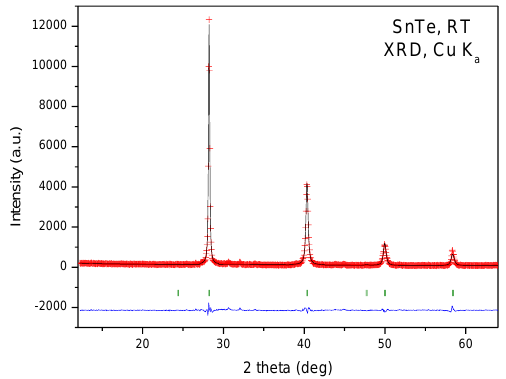
Figure 1. XRD pattern of SnTe from laboratory equipment, with Cu Kα radiation.